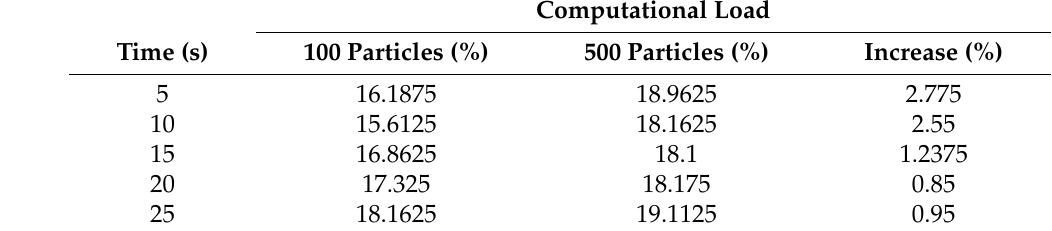
Table 4. Computational load with α = 0.5 during the test execution